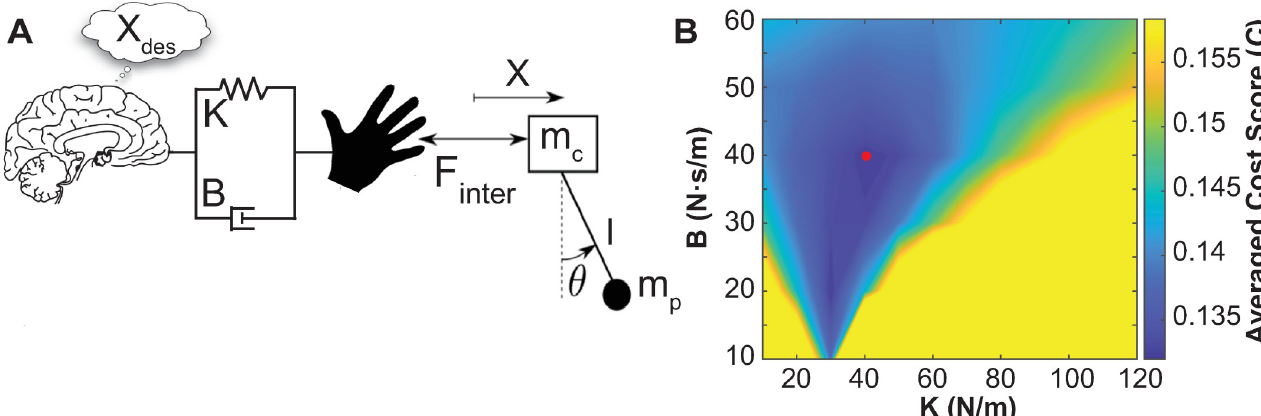
Fig 11. Model of hand impedance and estimation of impedance values: A. Control model with a first-order hand impedance coupled to the cup-and-ball system. The interactive dynamics is represented by a spring K , in parallel with a damper B . The desired trajectory is denoted as x C for all stiffness and damping combinations, fitted to the experimental data. C is the goodness of fit for given pairs of K and B to the human data. Yellow indicates impedance values that produce high C values and blue values that produce low C values. The global minimum at stiffness K = 40 N/m and damping B = 40 Ns/m, shown by the red point. This landscape is the point-wise average of all 1100 successful trials.